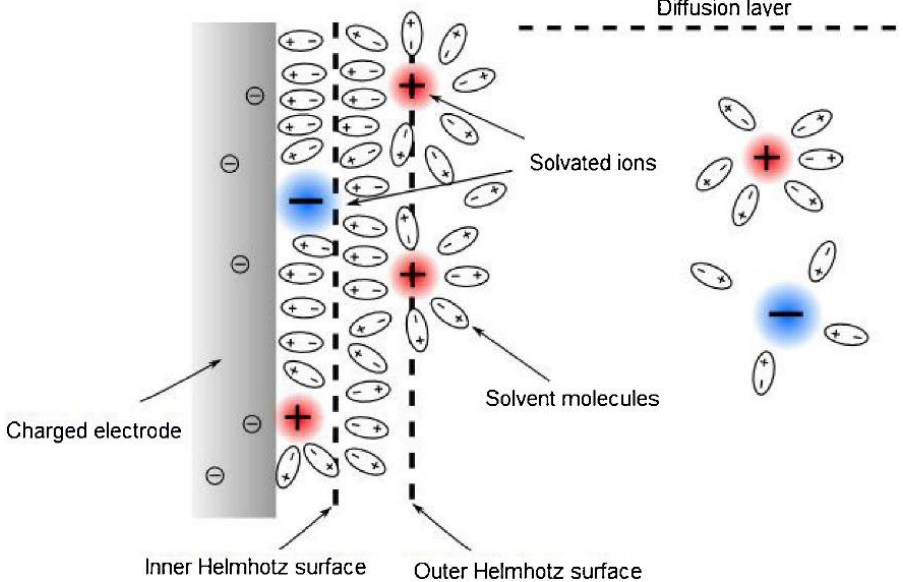
Figure 12. Helmholtz layer comprising the inner and outer Helmholtz surfacers and diffuse layer developed on the interface between the electrolyte and a charged electrode [102]. Used with permission from Elsevier.